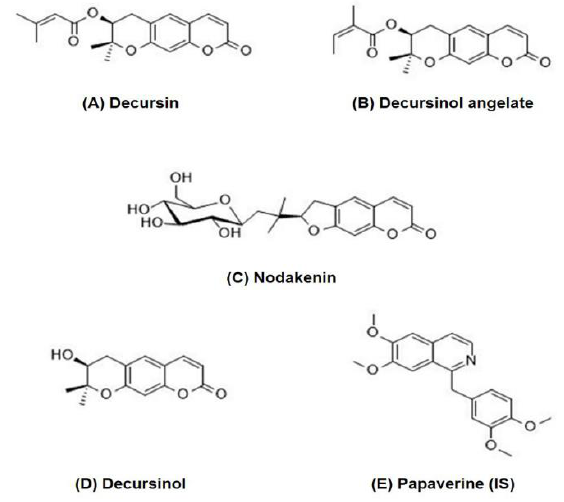
Figure 1. Structures of the four coumarins and papaverine as an IS. ( A ) decursin, ( B ) decursinol angelate, ( C ) nodakenin, ( D ) decursinol, and ( E ) papaverine (IS).